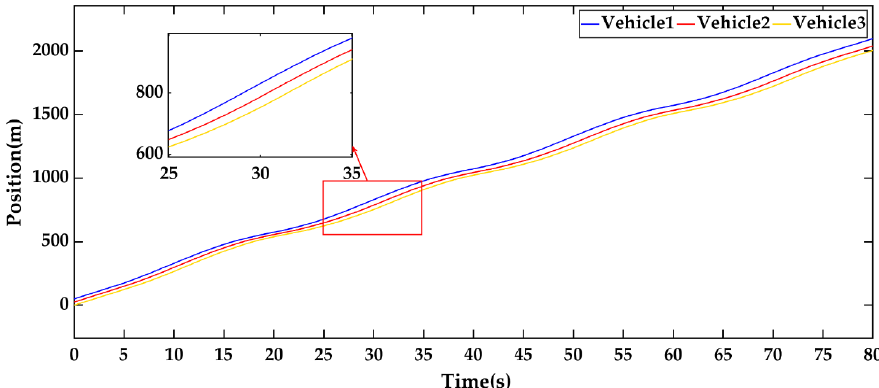
Figure 22. The positions of the following vehicle under the improved MPC strategy in Scenario 2.